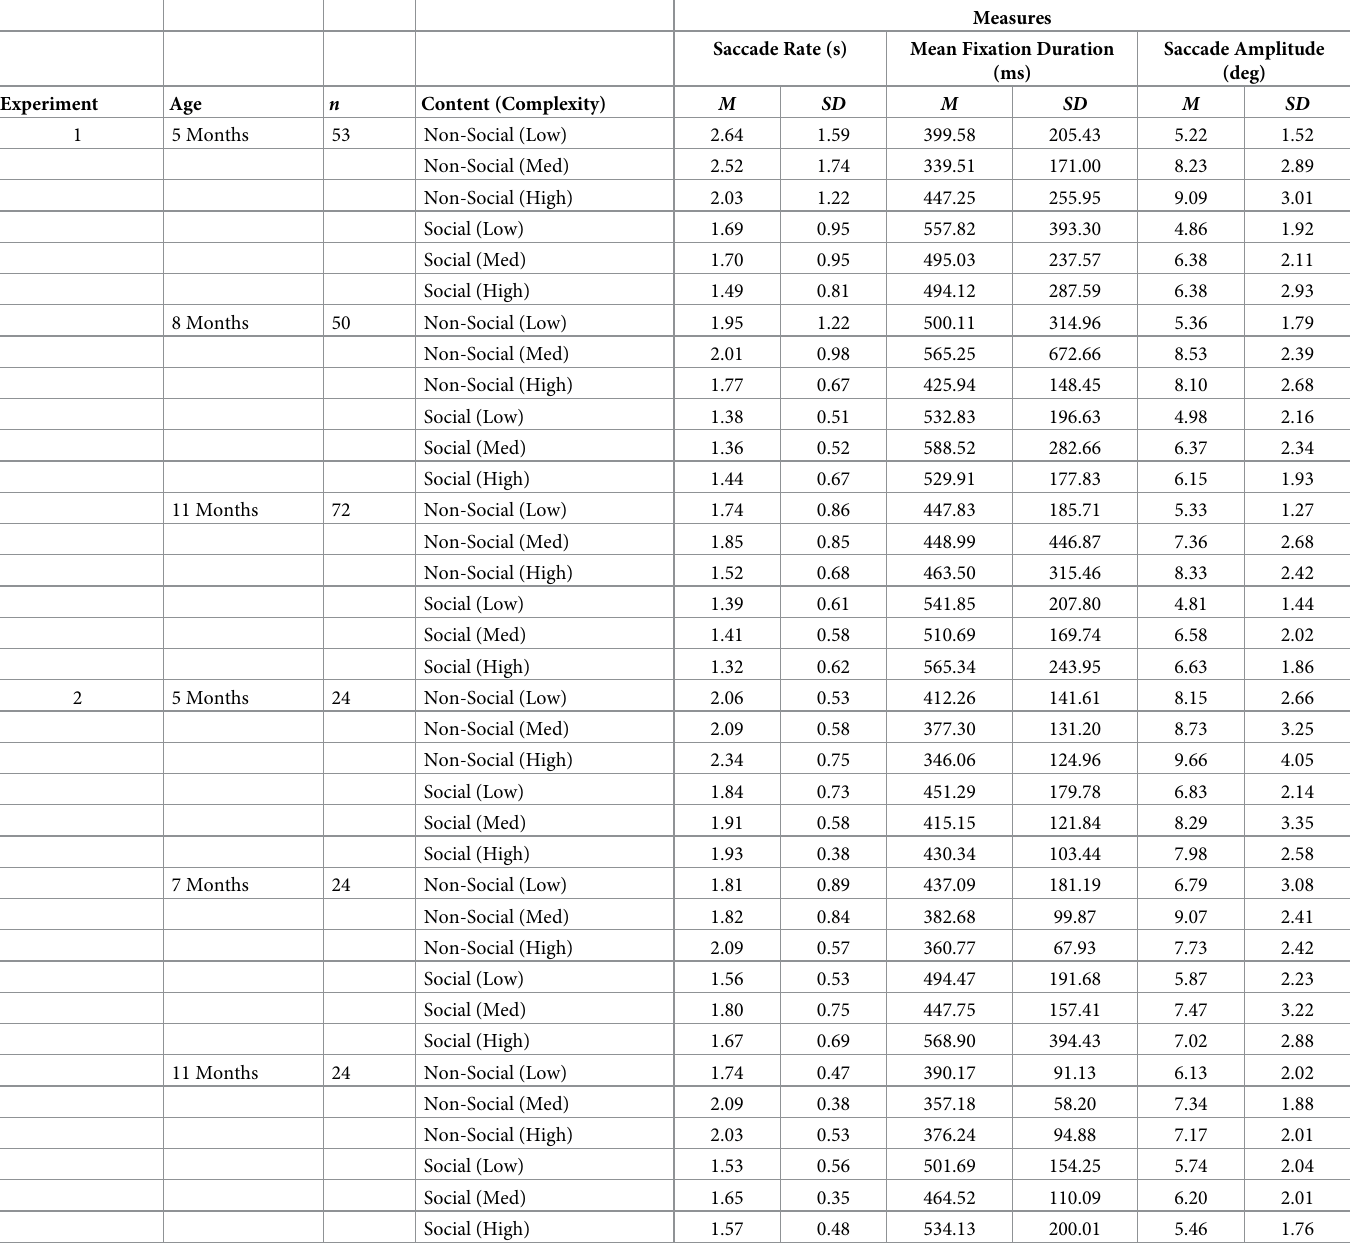
Table 1. Means, standard deviations, and sample sizes for all measures in Experiment 1 and Experiment